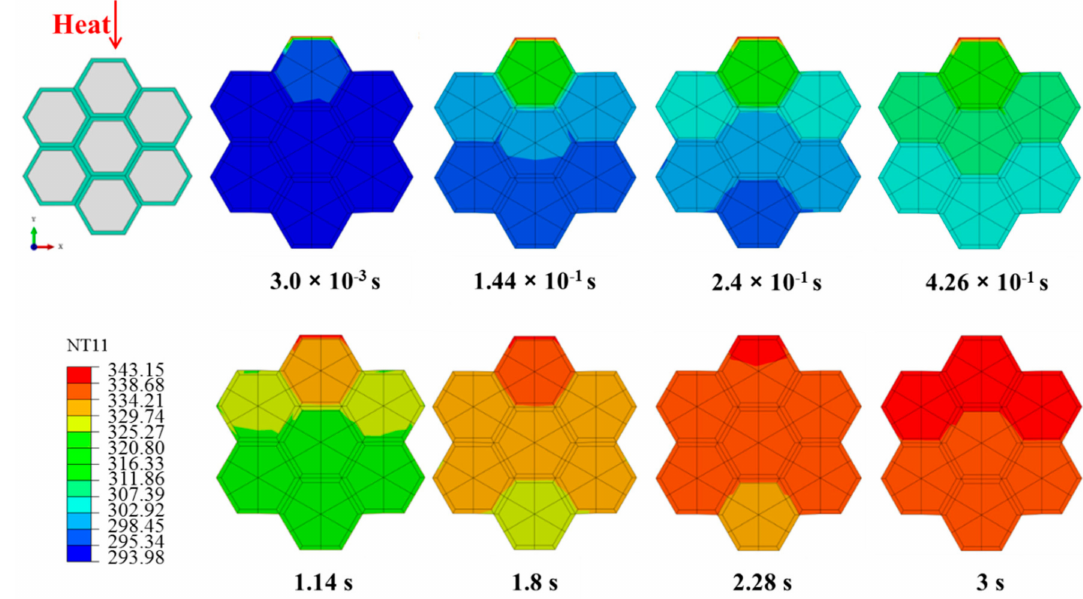
Figure 15. Temperature field distributions for transverse heat